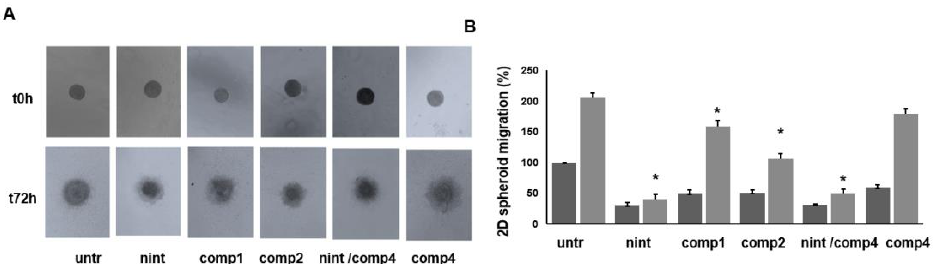
Figure 8. Inhibition of tumor spheroid flat surface migration. Hanging drop tumor spheroids were allowed to spread on a 2D fibronectin-coated flat surface. ( A ) Representative images of flat surface 2D migration of tumor spheroids after the exposure to nintedanib, compounds 1, 2 , the combination of compound 4 with nintedanib, or compound 4 . ( B ) Quantitative analysis of 2D migration. Data are representative of three independent experiments ( n = 6) and expressed as means ± SEM. * p < 0.05 vs. untreated spheroids.